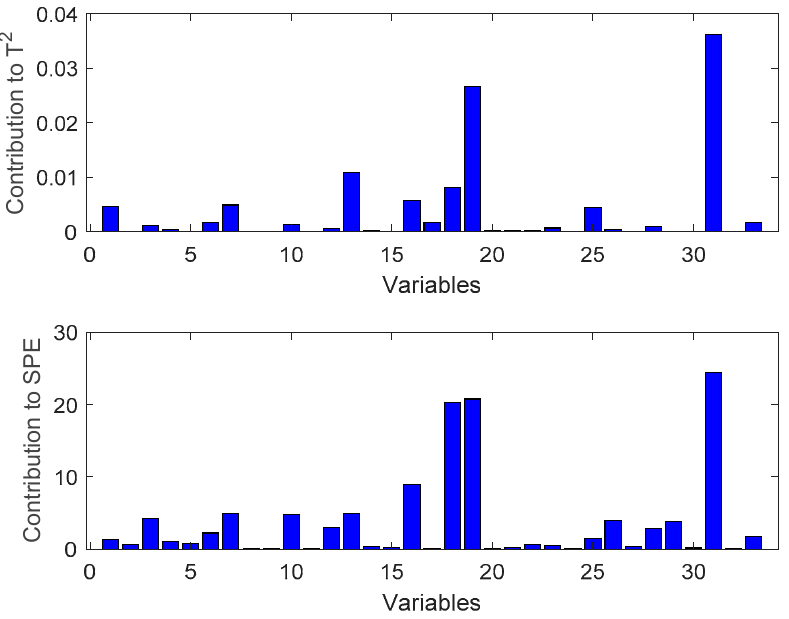
Figure 6. Fault diagnosis diagram of fault 10.